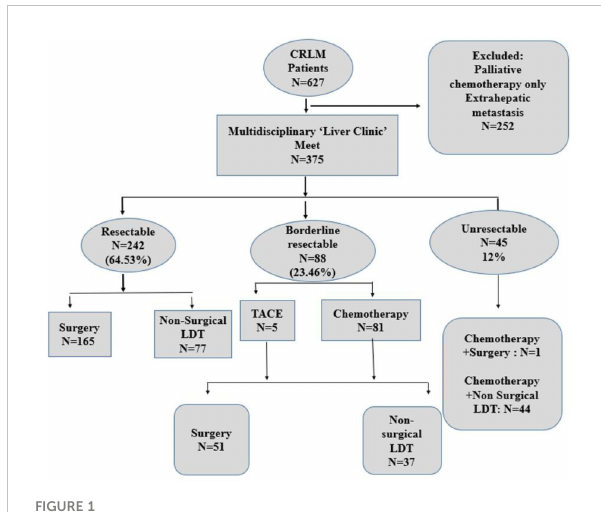
FIGURE 1 CONSORT diagram depicting the subgroups as per resectability criteria and treatment received.